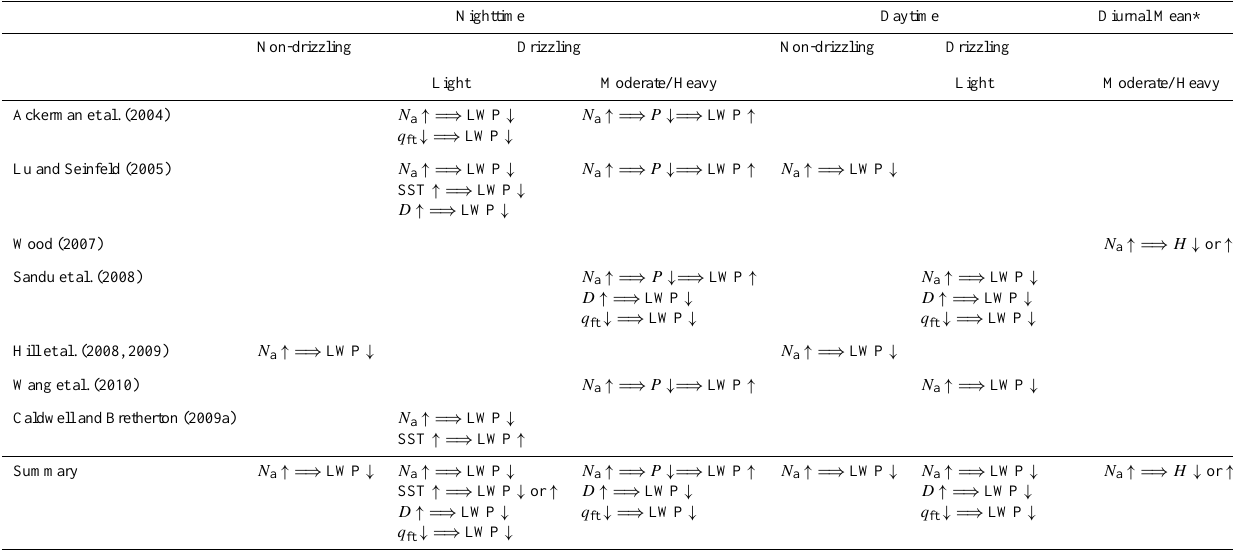
Table 1. Studies of aerosol-cloud interactions in MSc.